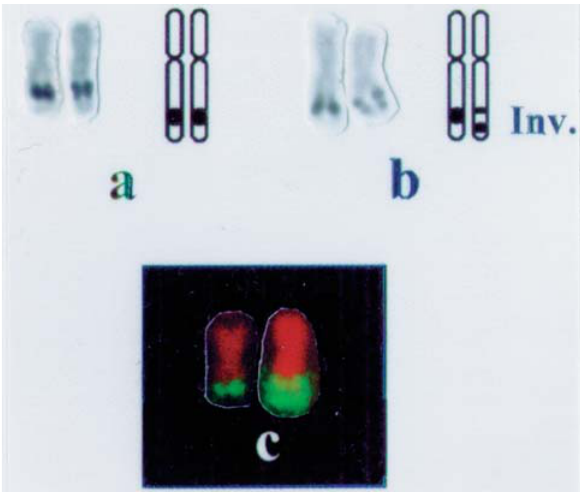
Figure 1 - Photomicrographs and schematic drawings of silver nitrate- stained NOR-bearing chromosomes of rainbow trout ( Oncorhynchus mykiss ). a) Chromosome pair and corresponding diagram of a homozy- gous N1N1 individual, showing the NOR located at an interstitial position on the long arm. b) Chromosome pair of an N1N2 individual heterozy- gous for a paracentric inversion involving the NOR-bearing segment of the chromosome. The diagram shows the inverted region (Inv). c) Fluo- rescent in situ hybridization using biotinylated 18S rDNA for chromo- somes of rainbow